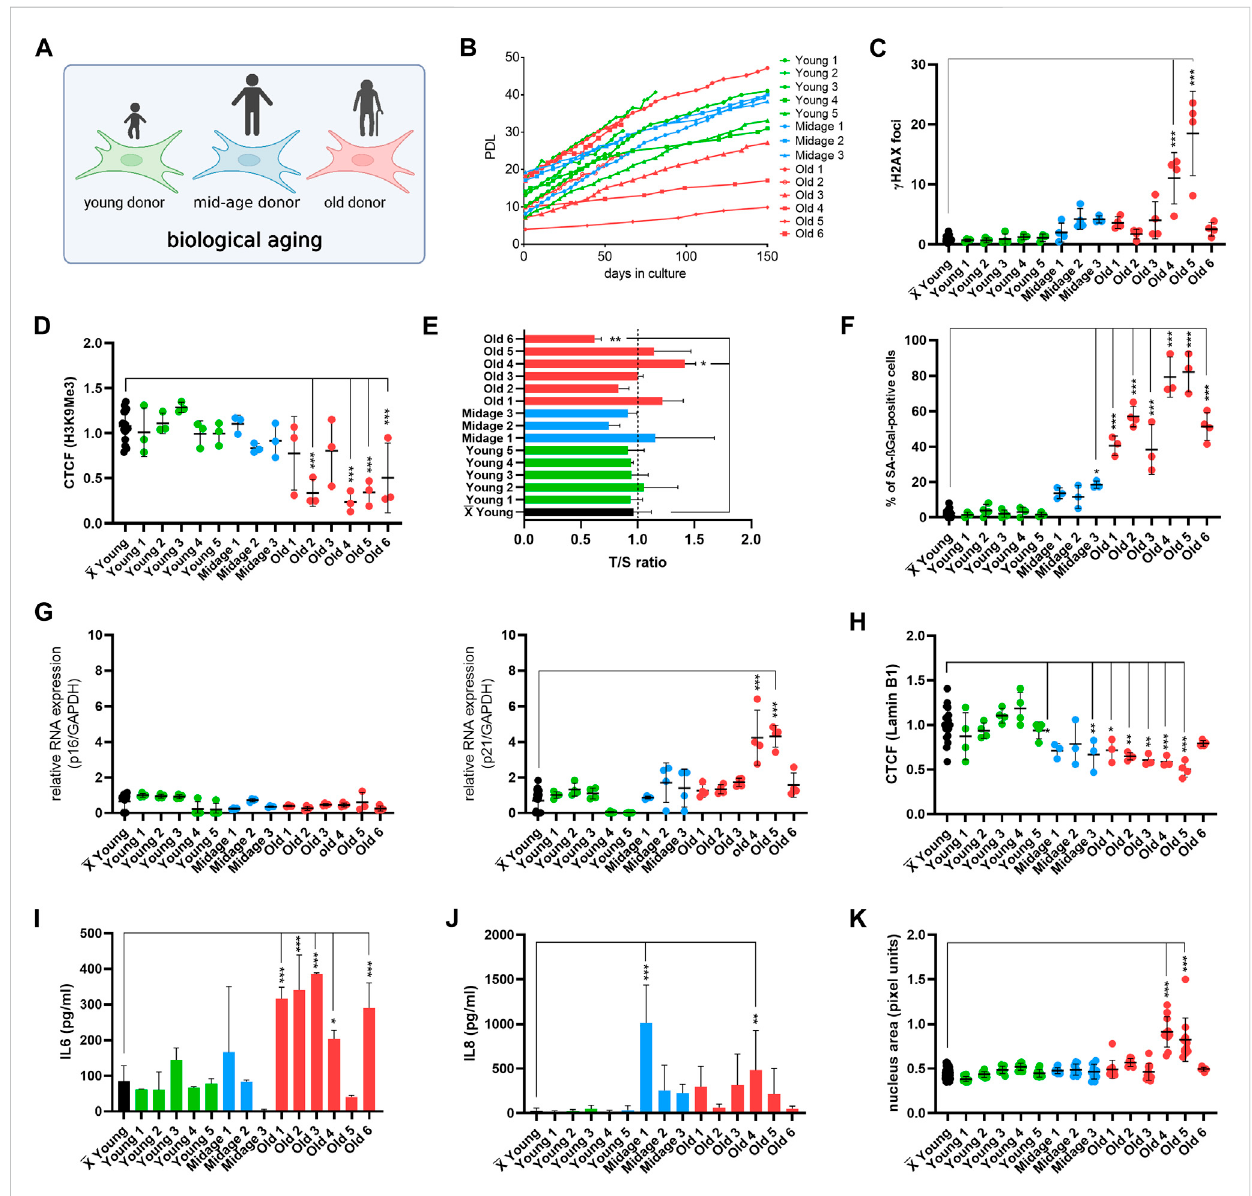
FIGURE 2 Establishment of the age marker-based panel in human fi broblasts of young, mid-age and old donors. (A) Cell Model. For initial experiments, fi broblastswithdifferentdonoragewasused. (B) Replicativepotentialofhuman fi broblasts.Cellswereculturedunderstableconditions(37 ° C,5%CO DMEMmedium(with15%FBS,1%Pen-Strep).PDLwasobservedformax.150days.Fibroblastsfromyoung(Young1 – 5)andmid-age(Midage1 – 3)donors display healthy growth. In contrast, fi broblasts from old donors (Old 3, Old 4, Old 5 and 6) showed slower growth except for Old 1 and Old 2. (C – K) X (cid:1) =Meanvalueofallyoungdonor fi broblasts. (C) Amountof γ H2A.XfocipercellexaminedbyIFstainingtoinvestigateDSBsinhuman fi broblasts.Cellsof very old individuals (Old 4 and 5) displayed an increase in γ H2A.X foci in comparison to the mean of all young donors. Mid-age and old (Old 1, Old 2, Old 3andOld6)donor fi broblastshowednoDSBs.[ n =3 – 4(eachntested > 15cells),mean±SEM,* p < 0.05,** p < 0,001,***p < 0.0001, one-wayANOVA] (D) CTCF of H3K9Me3 in human fi broblasts. Donor fi broblasts from old individuals (Old 2, Old 4, Old 5 and Old 6) displayed a decrease in CTCF of H3K9Me3 compared to the mean of young donors. There were no changes in CTCF of H3K9Me3 in mid-age cells (Midage 1 – 3). [ n = 3 – 4 (each n tested > 15cells),mean±SEM,* p < 0.05,** p < 0.001,***p < 0.0001 ,one-wayANOVA] (E) TelomerelengthwasmeasuredbyMM-qPCRincomparisonto a standard of healthy mixed aged individuals. In comparison to grouped young donor cells, Old 6 displayed a shortening of telomere length. [ n = 3, mean ± SEM, * p < 0.05, ** p < 0.001, ***p < 0.0001 , one-way ANOVA] (G) RNA expression levels measured by qRT-PCR of p21 and p16 was examined to investigate activation of cell cycle arrest. Old 4 and Old 5 displayed an increase in RNA expression level of p21. All other cells did not show altered RNA expression levels. [ n = 3-4, mean ± SEM * p < 0.05, ** p < 0.001, ***p < 0.0001 , one-way ANOVA] (F) Quanti fi cation of SA- β GAL positive cells by X-Gal staining. In comparison to grouped young donor cells, Midage 3 and all old human fi broblasts (Old 1 – 6) displayed a signi fi cant increase of SA- β GAL positive cells.[ n =3 – 4(eachntested > 15cells),mean±SEM,* p < 0,05,** p < 0.001,***p < 0.0001 ,one-wayANOVA] (H) CTCF ofLaminB1expression.A signi fi cant decrease in Lamin B1 expression could be observed in mid-age (Midage 1 and Midage 3) and old (Old 1 – 5) cells compared to the mean of young donor fi broblasts. [ n = 4 (each n tested > 15 cells), mean ± SEM, * p < 0.05, ** p < 0.001, ***p < 0.0001 , one-way ANOVA] (I, J) Determination of cytokine secretion (IL-6, IL-8) in conditioned medium by ELISA. In comparison to grouped young donor cells, old donor fi broblasts (Old 1, Old2, Old 3, Old 4, and Old 6) showed an increase in levels of IL-6. An increase in concentration with respect to IL-8 could be observed in Midage 1 and Old 4 in comparison to grouped controls. [ n = 3-4, mean ± SEM, * p < 0.05, ** p < 0,001, ***p < 0.0001 , one-way ANOVA] (K) Change in nucleus morphology shown as nucleus area (pixel units) in human fi broblast. Nucleus area is signi fi cantly increased in very old donor fi broblasts (Old 4 and 5) compared with grouped young controls. [ n = 6 – 8 (each n tested > 15 cells), mean ± SEM * p < 0.05, ** p < 0.001, ***p < 0.0001 , one-way